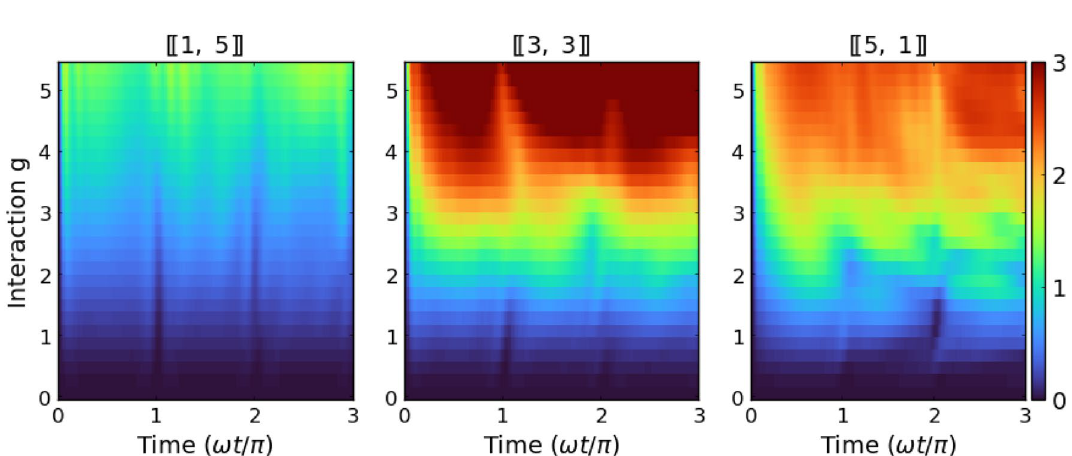
6 particles Figure 8. Time evolution of the von Neumann entropy S ( t ) calculated for systems with N = 4.0 as a function of quench strength. It is clear that the and different imbalances and fixed mass ratios µ = entanglement production is rather weak and regular for the heavy-impurity system (left column) while becomes enhanced when particle imbalance is shifted towards the light-impurity case (right